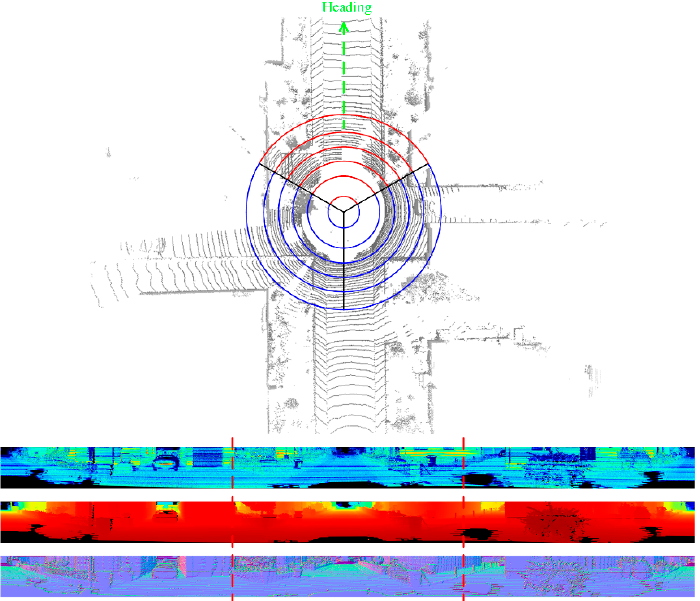
Figure 9. Schematic diagram of weight matrix assignment.